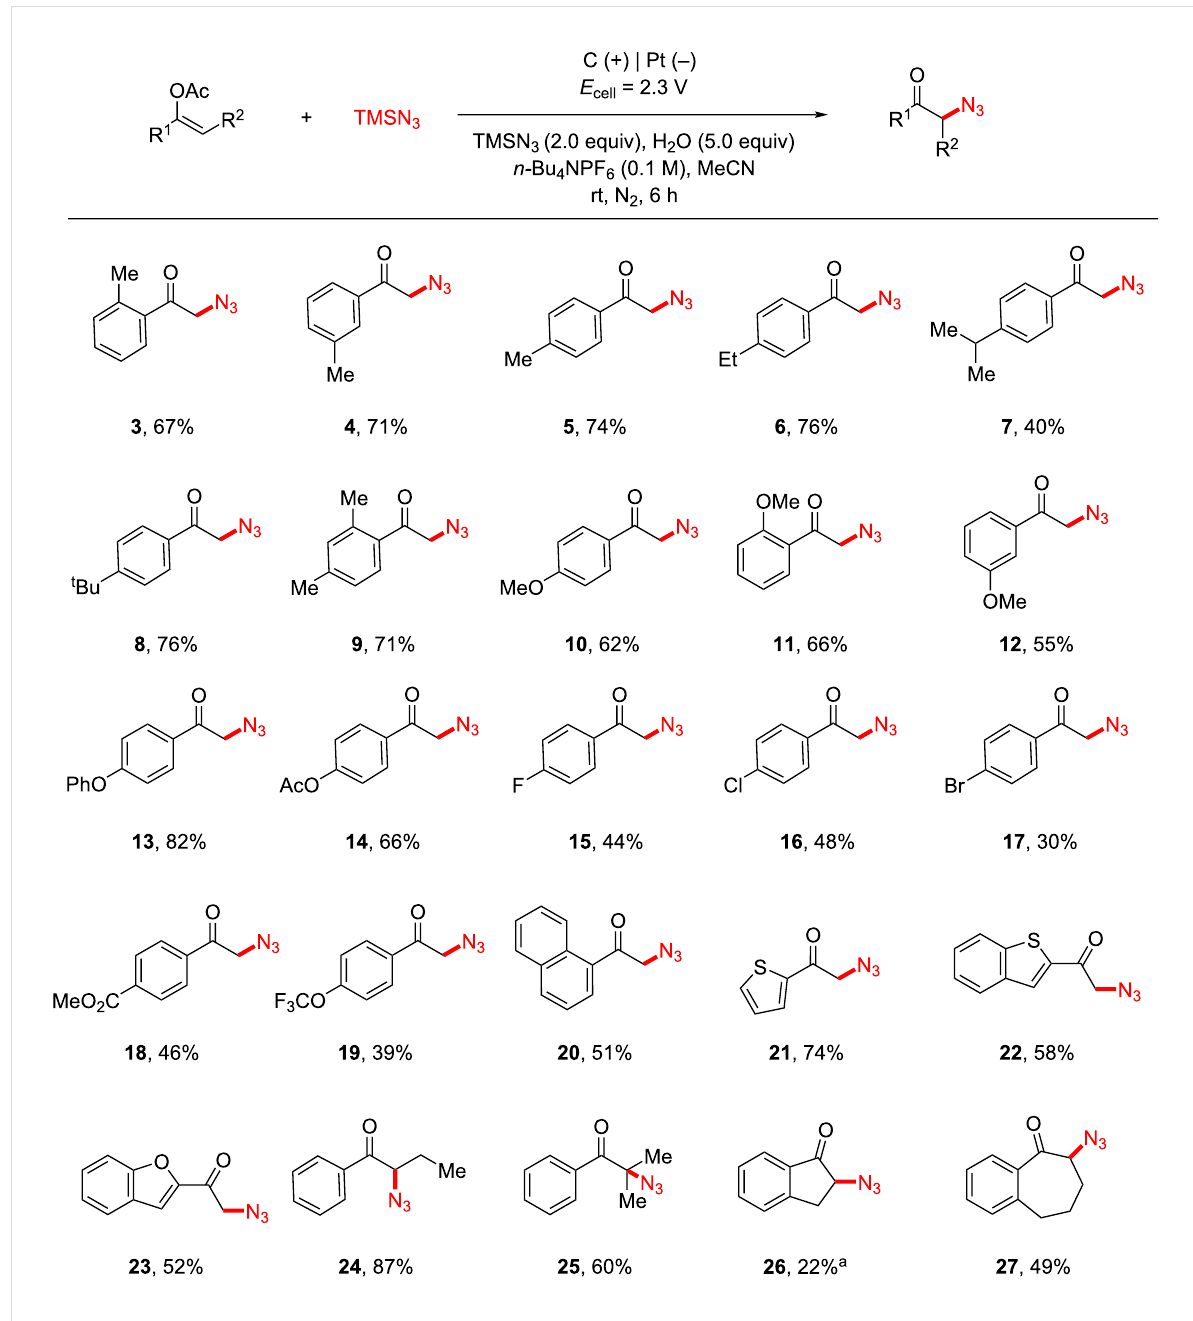
tones were generally well tolerated ( 3 – 9 , 40–76% yields). The relatively low yield of the isopropyl-substituted one ( 7 ) was at- tributed to the competing oxidation of the isopropylbenzene moiety [31,36], which was consistent with its relative low oxi- dation potential ( E onset = 1.68 V vs Fc +/0 ). Other electron- donating substituents, such as the OMe ( 10 – 12 ), OPh ( 13 ), and OAc ( 14 ) were also well